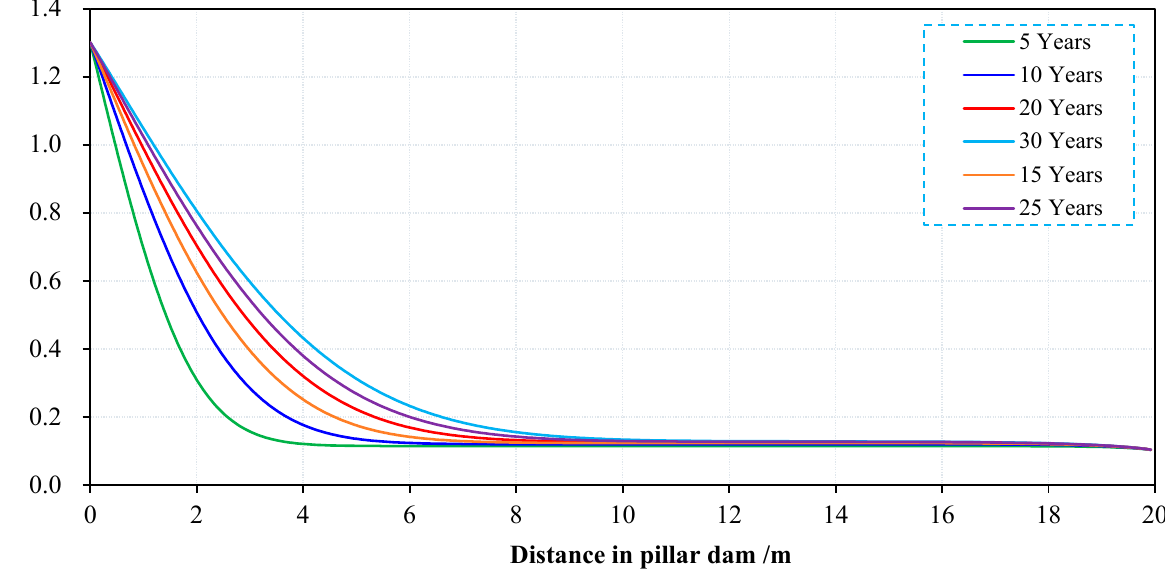
Figure 3. Distribution of pore pressure in the coal pillar of the underground reservoir with a depth of 100 m.